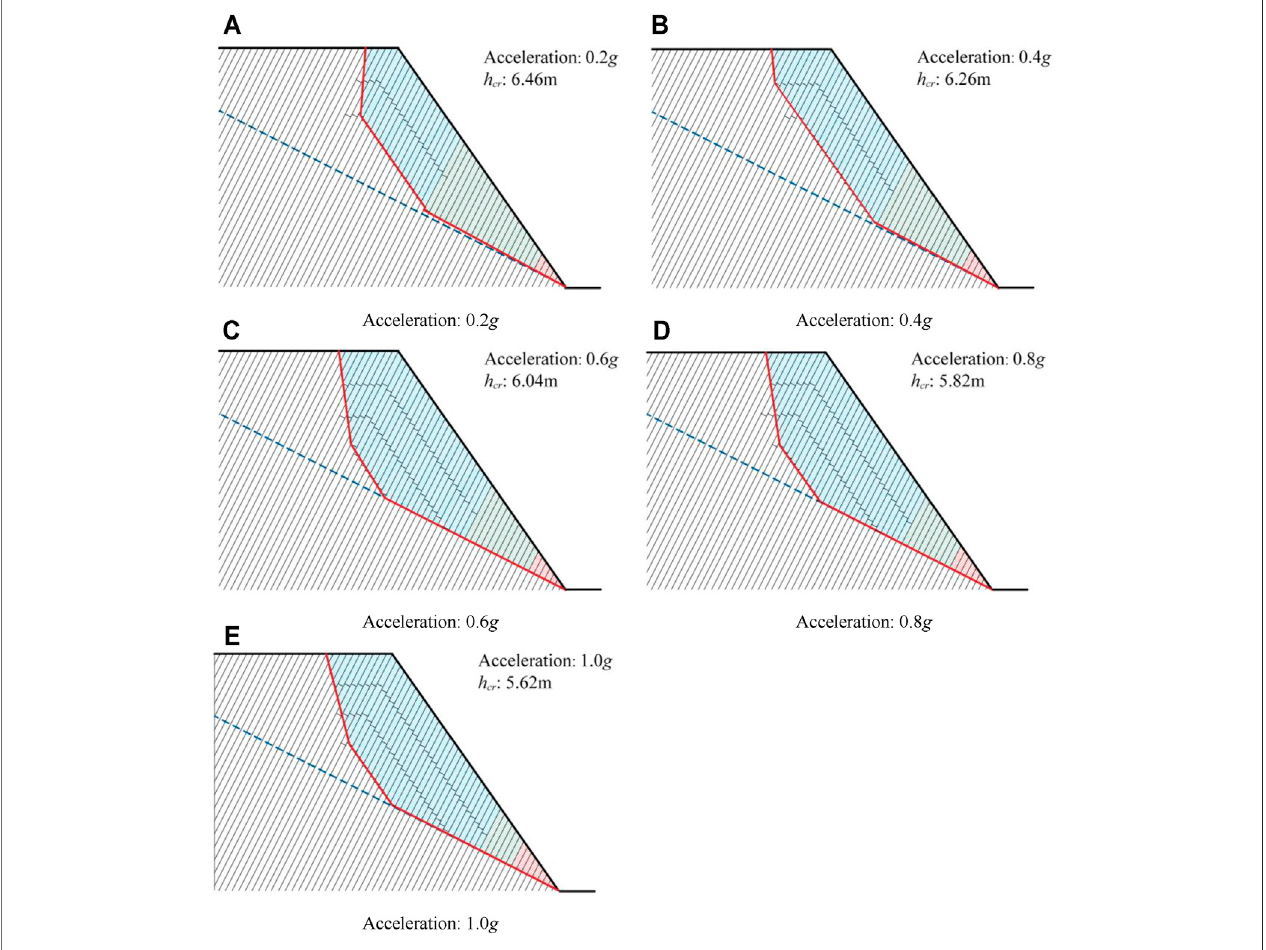
FIGURE 10 | Stability analysis of the anti-dip rock slope in southern Anhui under different seismic loads. (A) Stability analysis at 0.2 g acceleration; (B) Stability analysis at 0.4 g acceleration; (C) Stability analysis at 0.6 g acceleration; (D) Stability analysis at 0.8 g acceleration; (E) Stability analysis at 1.0 g acceleration.